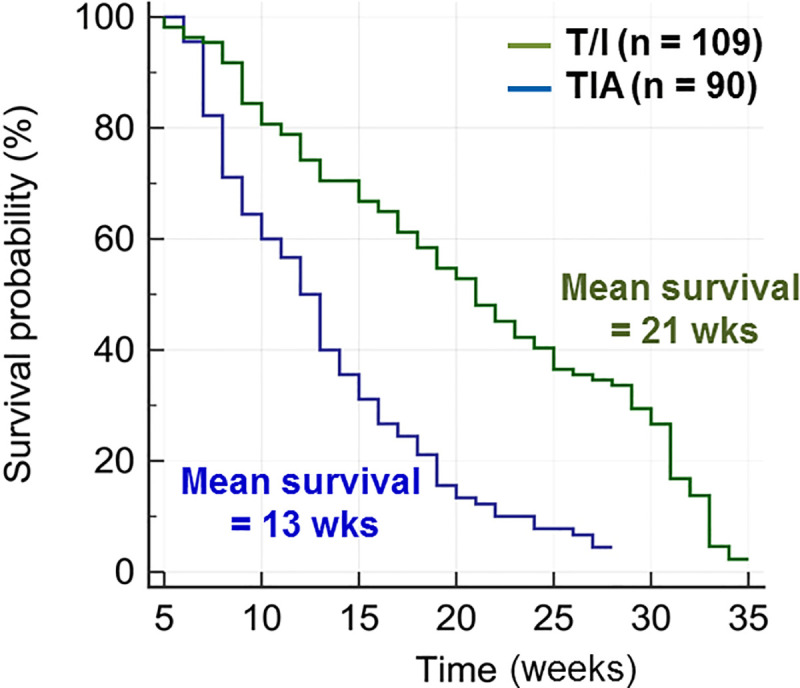
Survival of T/I and TIA mice as a function of age.To prevent unnecessary suffering, morbidity that triggered humane endpoints was used as a surrogate for mortality, as described in Materials and Methods. Kaplan-Meier analysis demonstrates that TIA mice have a significantly shorter mean survival (13 weeks) than T/I mice (21 weeks; p = 0.0001, log-rank test).